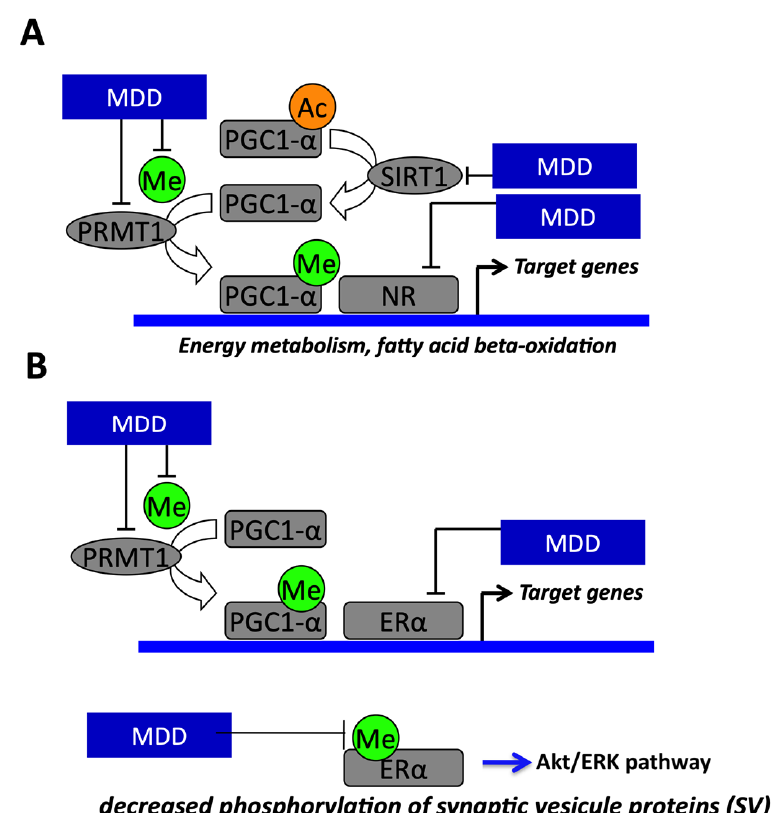
Figure 3. Molecular mechanisms demonstrating the link between methyl donor deficiency (MDD) and fetal programming and energy metabolism in liver and heart and regulation of synapsin expression in neuron. ( A ) The e ff ects of fetal programming on the heart, liver and brain of rats born from methyl donor deficient (MDD) mothers are related to impaired PGC-1 α activity through decreased expression of Sirtuin1 (Sirt1) and protein arginine methyltransferase (PRMT1) and decreased synthesis of the universal methyl donor (Me) methyl S- adenosyl methionine (SAM). The decreased activity of PGC-1 α results from imbalanced methylation and acetylation. PGC-1 α is a regulator of lipid metabolism and fatty acid oxidation through its role as coactivator of PPAR α in heart and liver. ( B ) MDD induces decreased phosphorylation of synaptic vesicle proteins through impaired ER α activity linked to decreased SAM levels, PMRT1 expression and PGC-1 α activity. PGC-1 α is a regulator of synapsin expression and vesicle transport through its role as a coactivator of ER α in the brain. The impaired cellular availability of vitamin B12 leads to ER stress related to decreased expression of Sirt1. ER stress is evidenced by increased expression and activation of elf2- α and activating transcription factor 6 (ATF6) and may be favored by decreased expression of heat shock proteins (HSP). Decreased Sirt1 impairs the transcription of HSP by increasing the acetylation of heat shock protein factor 1 (HSF1; Figure 4) [93]. Conversely, overexpression of Sirt1 and HSF1 and activation of Sirt1 by SRT1720 as well as addition of vitamin B12 induce a dramatic decrease of ER stress in NIE115 neuronal cells with impaired cellular B12 availability [93]. Similarly, ER stress is increased in fibroblasts of cblC, cblG and cblG* patients with inherited disorders of cellular vitamin B12 metabolism [100]. Some of the molecular mechanisms that underlie the neurological manifestations of patients with inherited disorders of vitamin B12 metabolism are related to transcriptomic changes of genes involved in RNA metabolism and ER stress. The transcriptomic changes result from the subcellular mislocalization of several RNA binding proteins (RBP), including the ELAVL1 / HuR protein implicated in neuronal stress and HnRNPA1 and RBM10, in patient fibroblasts and Cd320 knockout mice with impaired cellular uptake of vitamin B12. The decreased interaction of ELAVL1 / HuR with the CRM1 /